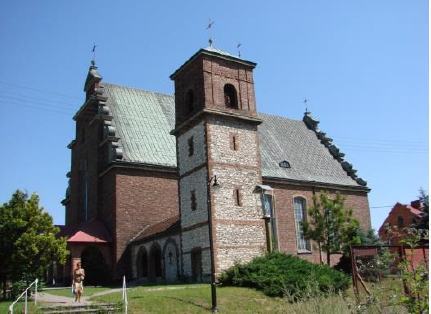
Figure 3. Church of the Elevation of the Holy Cross in Częstochowa (built in 1949–54).